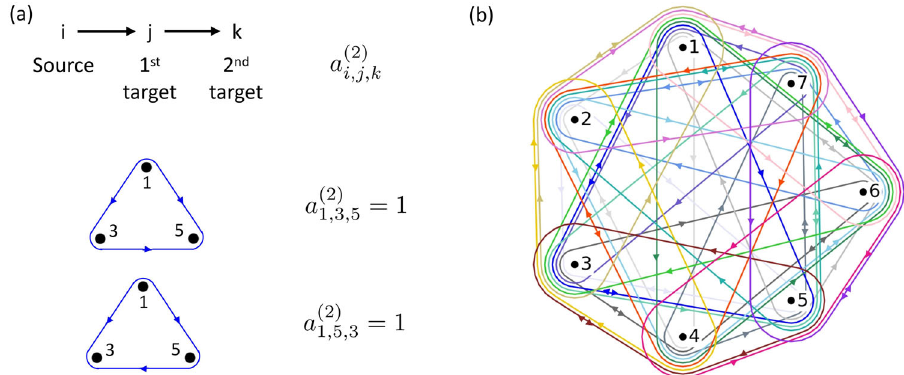
Fig. 5 An example of optimal network with directed 2-hyperlink interactions that preserves symmetry. a An illustration on the direction in directed 2-hyperlink interactions. The tensor a ð 2 Þ has its subscript indices separately as source, 1st target, 2nd target nodes as in 56 . Two directed 2-hyperlinks i ; j ; k ¼ 1, a ð 2 Þ ¼ 1 are shown. b The 7-node network with directed 2-hyperlink interactions. The colored triangles denote various directed corresponding to a ð 2 Þ 1 ; 3 ; 5 1 ; 5 ; 3 ¼ 1, a ð 2 Þ ¼ 1 in total have the arrows 1 → 3, 1 → 5, 3 → 5, 5 → 3 2-hyperlink interactions, as given by Eq. (17). For example, two directed 2-hyperlinks a ð 2 Þ 1 ; 3 ; 5 1 ; 5 ; 3 by the rule de fi ned in panel a for setting the directed 2-hyperlink. This 7-node network supports that the structurally symmetric network can be optimal in synchronization for 2-hyperlink interactions. Differently, the optimal directed networks with pairwise interactions are always structurally asymmetric